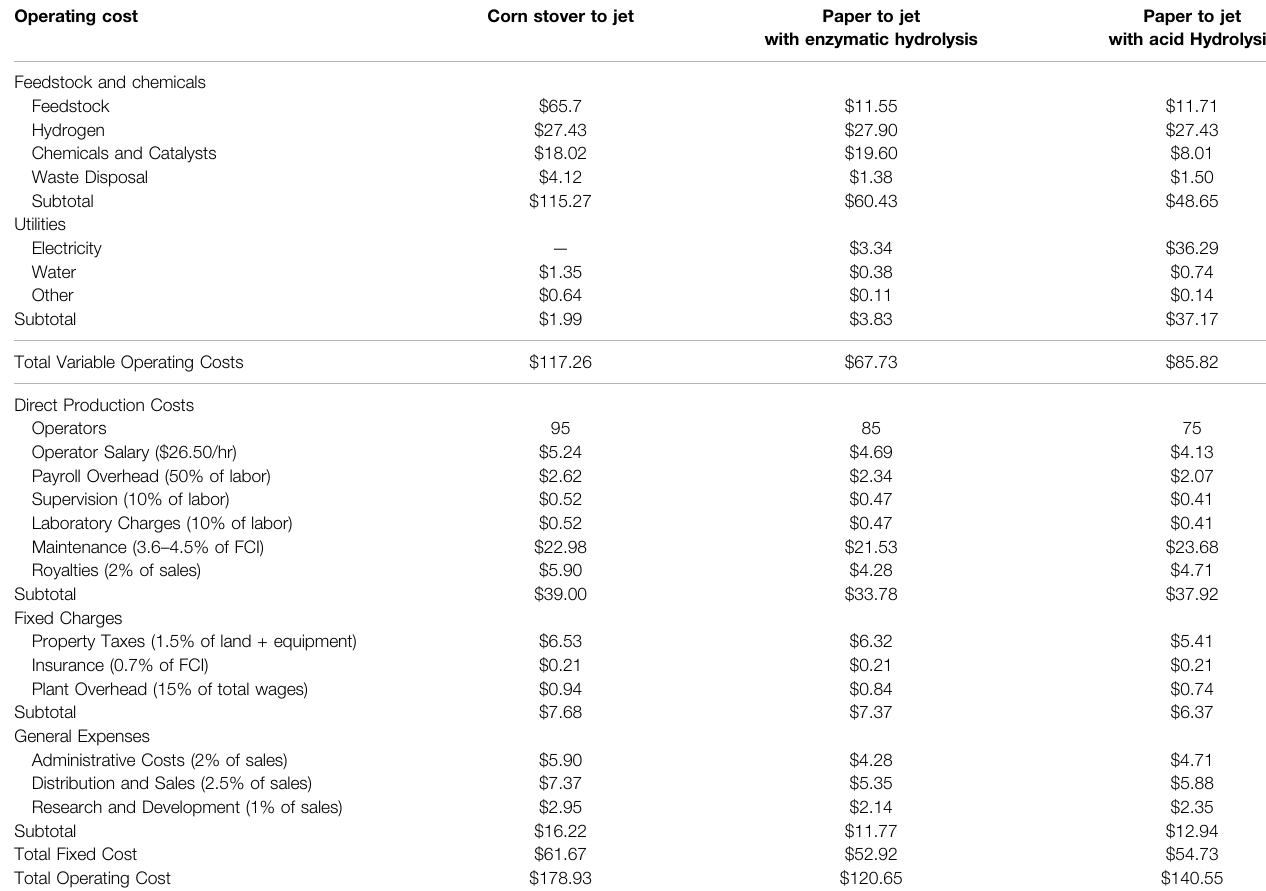
TABLE 6 | Annual Operating Cost in million USD (2020). Operating cost